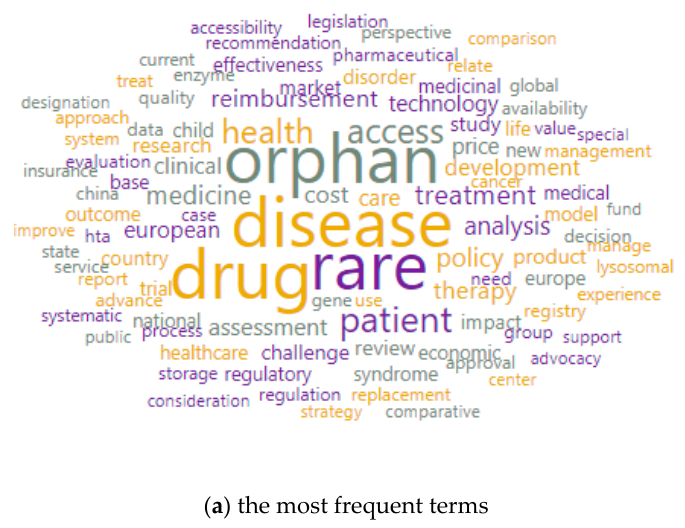
Figure 2. Word clouds of terms. Limitations: the authors did not take into account many valuable publications in the study, instead taking into account the need to narrow the thematic scope of